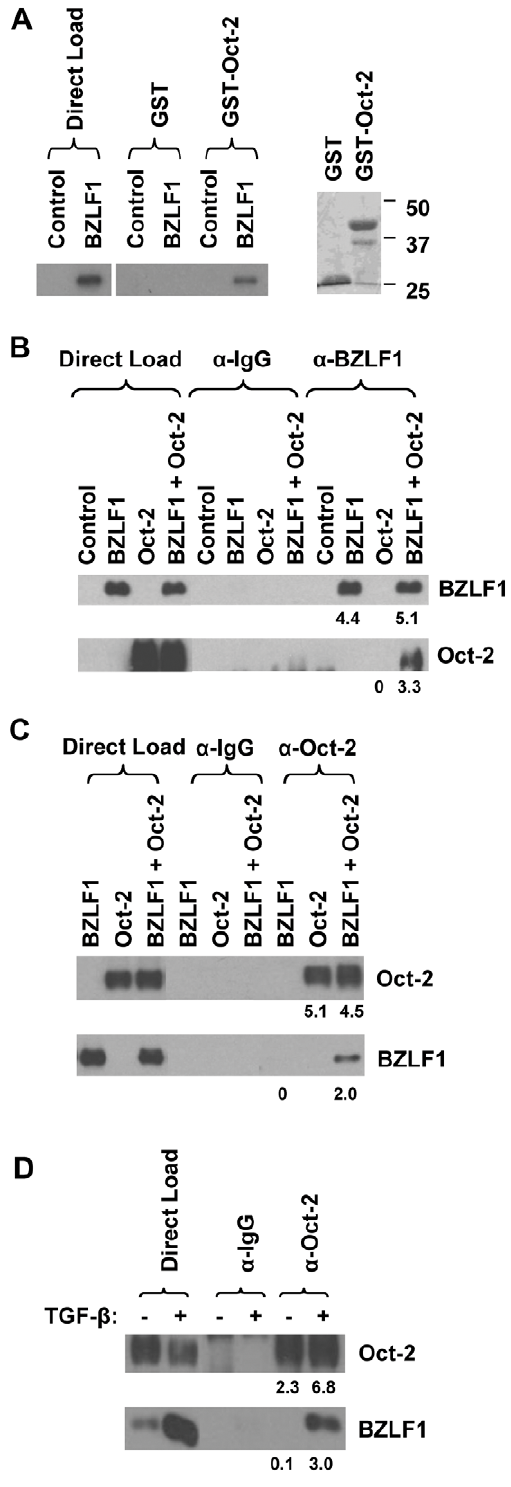
Figure 5. BZLF1 interacts directly with Oct-2 invitro and invivo . (A) (Left panel) GST pull-down assays were performed using GST or GST- Oct-2 fusion proteins incubated with 35 S-labeled, in vitro -translated BZLF1 protein. Twenty percent of the direct load was used for autoradiography. (Right panel) A Coomassie stain demonstrating the levels of GST or GST-Oct-2 protein used in the GST pull-down assays. (B and C) EBV-negative HeLa cells were transfected with Oct-2 in the presence or absence of co-transfected BZLF1 and then